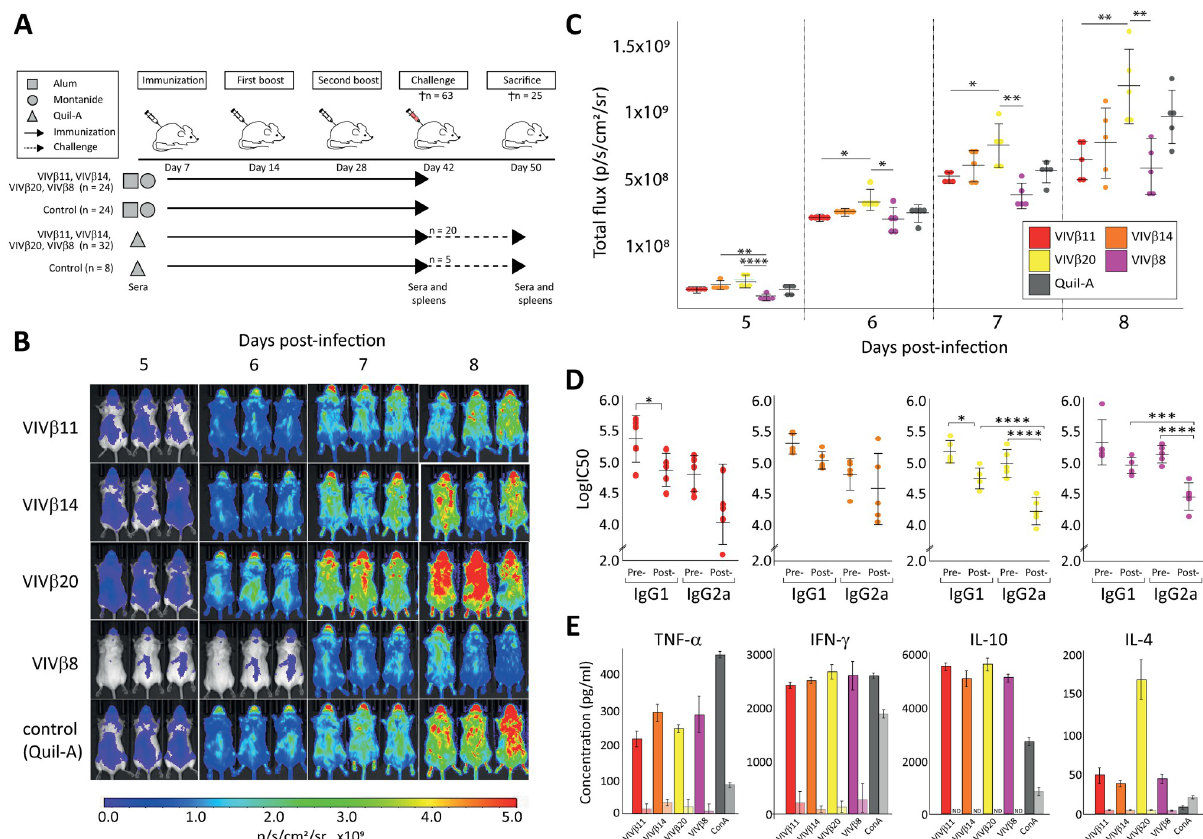
Fig 3. Vaccination and T . vivax challenge in a murine model. (A) Schedule of vaccine immunization and challenge. BALB/c mice received prime immunization followed by two boosts of a protein-in-adjuvant formulation. Each recombinant protein was combined with one of Alum, Montanide ISA 201 VG or Quil-A adjuvants, while the control groups received adjuvants only. Animals were euthanized at day 42 (n = 63) to assess the response to immunization, except for five mice from each vaccinated and control Quil-A-based groups (n = 25) which were challenged with bloodstream-form T . vivax for a further eight days. (B) Vaccine protection against challenge with bioluminescent T . vivax in BALB/c mice. In vivo imaging of immunized mice with each of four vivaxin antigens co-administrated with Quil-A (n = 5/group). Daily bioluminescent images were collected from 5-8dpi. (C) Parasite burden, measured as luminescent values (total flux in photons per second) of luciferase-expressing T . vivax in challenged mice at 8 dpi. (D) Humoral response before and after challenge with T . vivax in mice vaccinated with four antigens co-administered with Quil-A (n = 8). Comparison of isotype IgG in fully immunized mice at day 42 with challenged mice at 8 dpi. Serum concentration determined by ELISA. (E) Cytokine production by splenocytes stimulated in vitro after removal from fully immunized mice at day 42 (left-hand bar, full colour), compared with challenged mice at 8 dpi (right-hand bar, faded). Note that reductions in cytokine concentration post-immunization and post-challenge were significant (P < 0.001) for all antigens but labels are omitted for clarity. Data normality was confirmed with a Shapiro-Wilk test and statistical significance was assessed using a two- tailed ANOVA in R studio. Significance is indicated by asterisks: � (P < 0.05), �� (P < 0.01), ��� (P < 0.001), ���� (P < 0.0001).